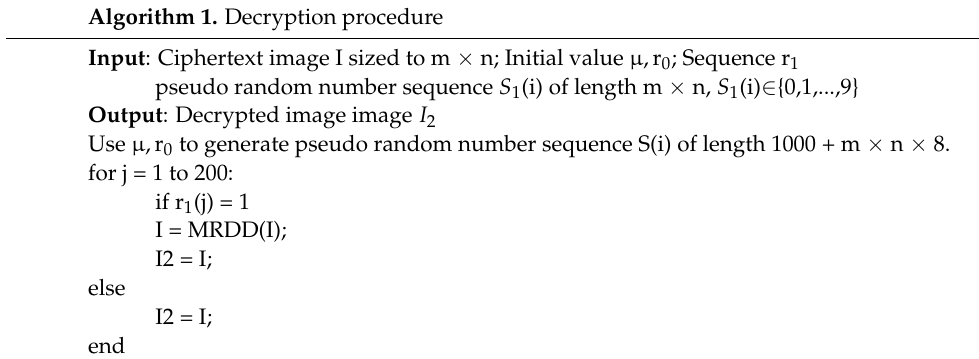
Algorithm 1. Decryption procedure